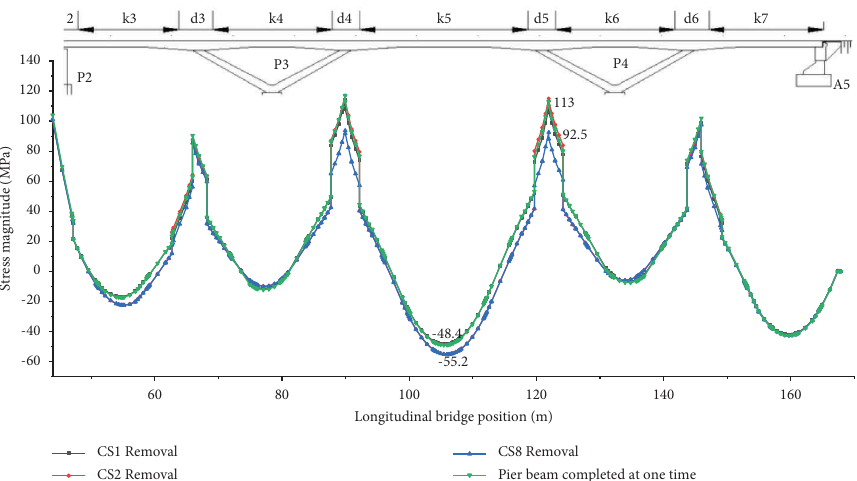
Figure 7: Stresses in upper fanges of steel beams.